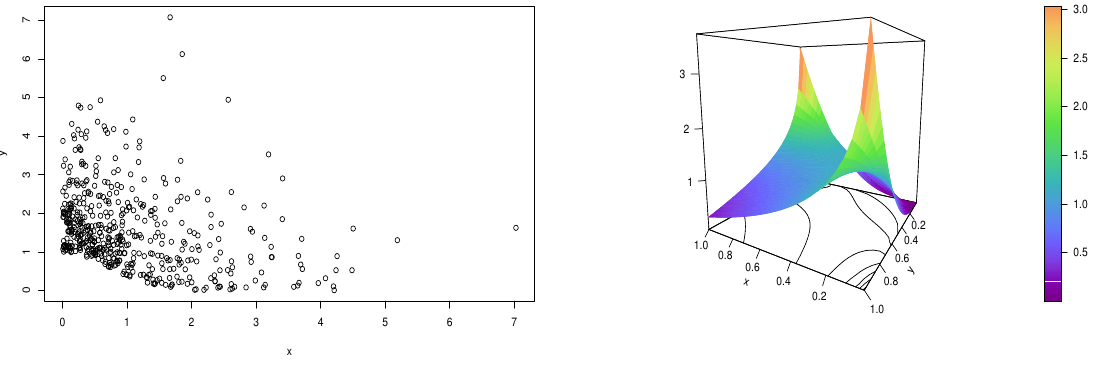
Figure 7. Scatter plot of the data ( left ) and plot of the estimated IP copula density ( right